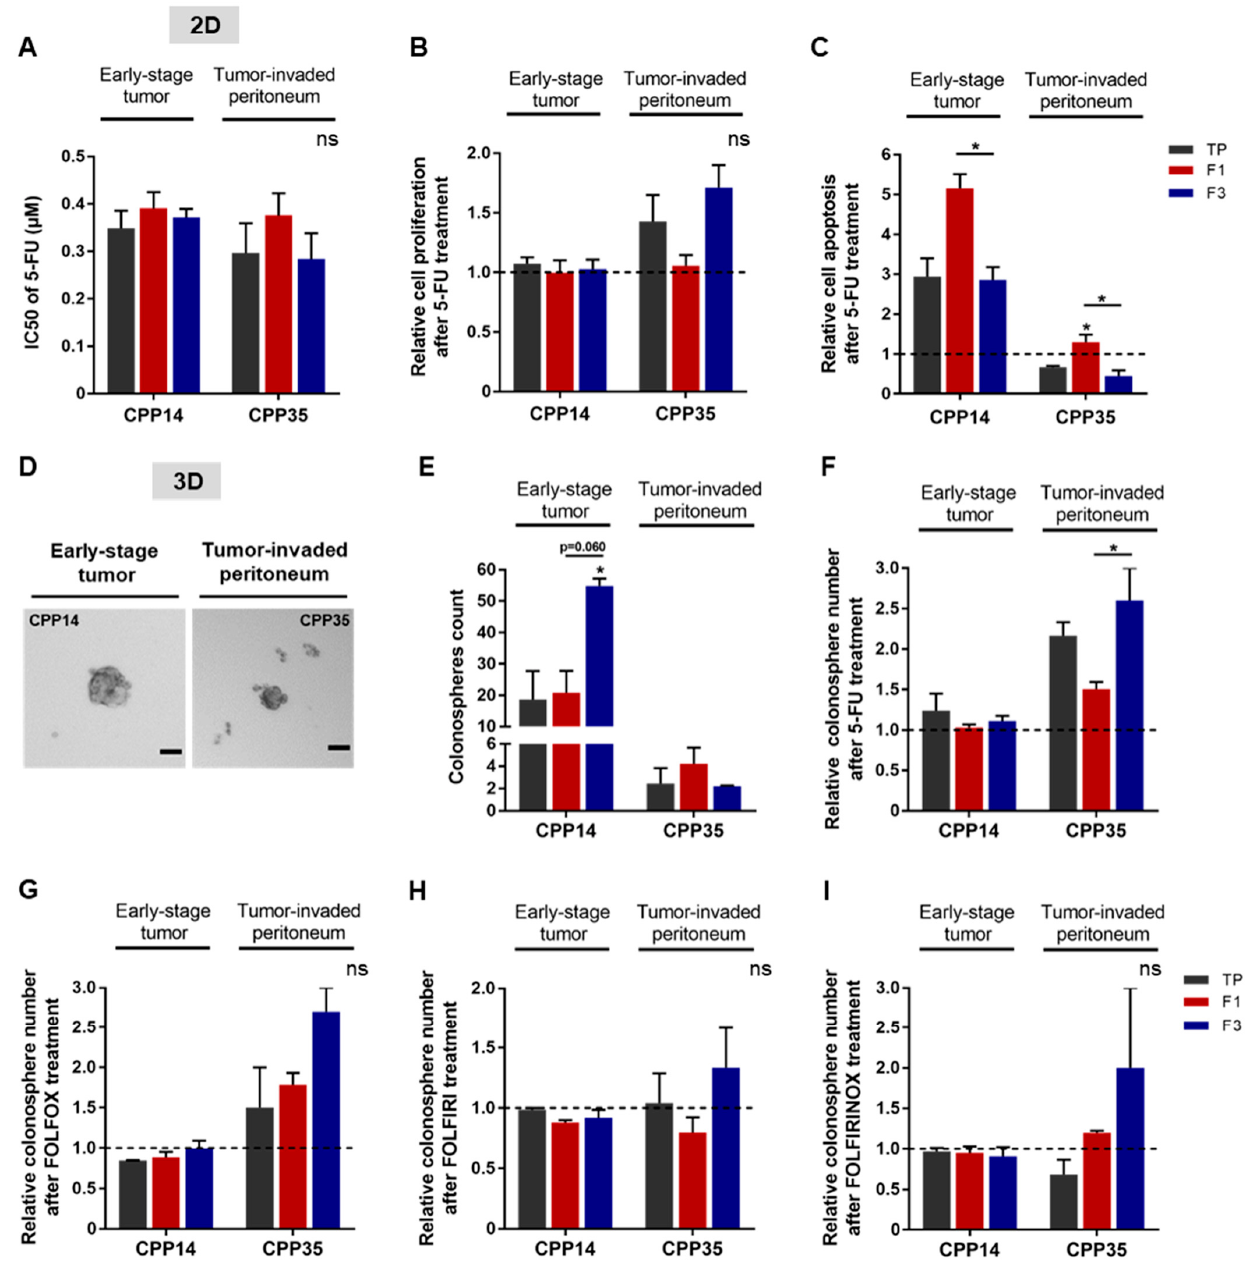
Figure 6. Chemoresistance of F3 subpopulation from both primary cultures. ( A ) After 5-FU treatment, cell viability was analyzed by MTT assay and presented as a bar plot with IC50 values obtained from all primary cultures. ( B ) Post-treatment induced proliferation was assessed by BrdU assay, comparing the results to the untreated condition (dashed line). ( C ) The apoptosis rate of both primary cultures was analyzed by ELISA cell death assay. ( D , E ) The tumorigenic potential of cells in vitro was evaluated by a sphere formation assay. In untreated condition, the ability of primary cultures to form colonospheres was presented as images of formed colonospheres (D) and their quantification summarized in the bar plot (E). Scale bar 50 μ m. ( F – I ) The impact of chemotherapies on CSC tumorigenic properties in vitro was investigated after treatment with 5 ‐ FU alone (F) or in combination: FOLFOX (G), FOLFIRI (H), or FOLFIRINOX (I). All these results are represented as means ± SEM and statistical differences with ns means a non ‐ significant result both between the sorted cell subpopulations and between a sorted subpopulation and the control, * p ‐ value < 0.05 and * alone for significant results compared to TP using one ‐ way ANOVA test.